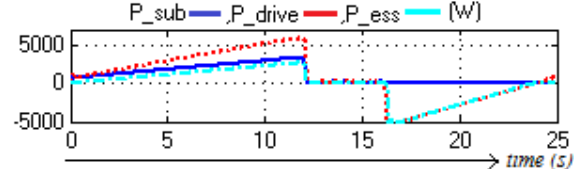
Fig. 15. Simulation diagram of power for both C = 31.5 F and C = 63